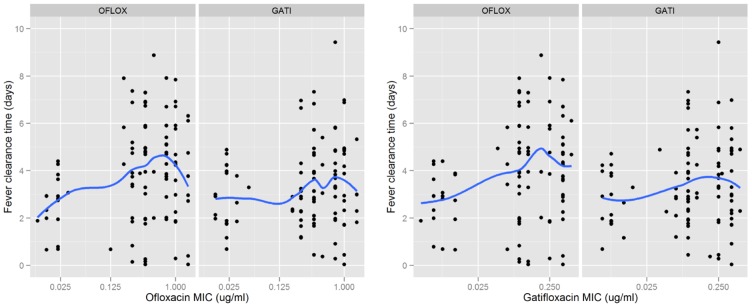
Scatter plots of drugs MIC versus fever clearance time.Gatifloxacin and ofloxacin MICs versus fever clearance time by treatment group for patients with blood culture confirmed enteric fever. Blue lines correspond to LOESS scatter plot smoothers.